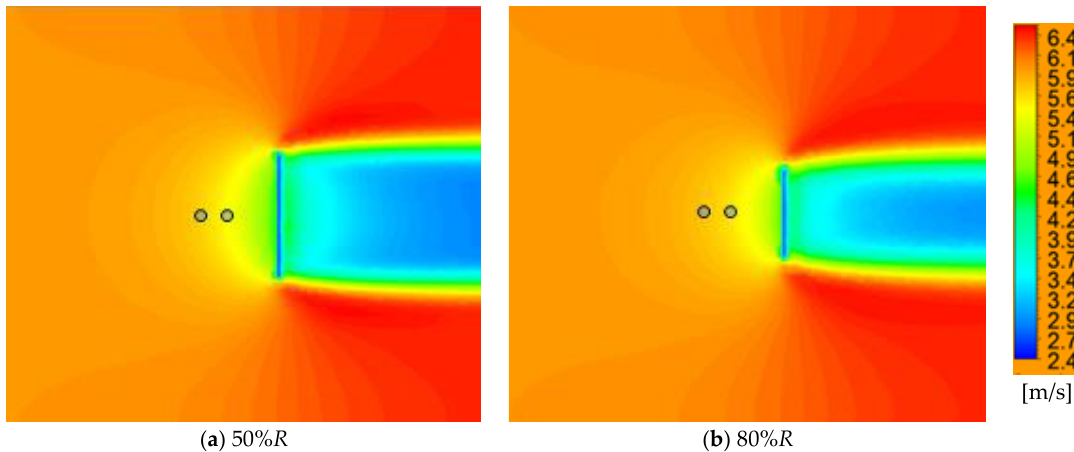
Figure 10. Wind speed distribution in front of the rotor at C T = 0.9, U 0 = 6 m/s. (The circles indicate the dummy tower positions at −6 D T and −4 D T ).